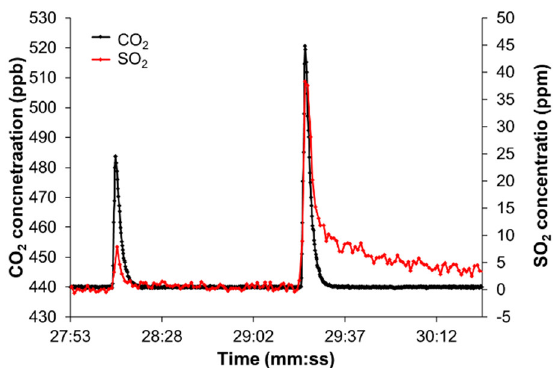
Figure 1. Graphs of CO 2 and SO 2 . The left peak is not impacted by VOCs, since SO 2 and CO 2 returned to background concentrations at the same time. The right peak of SO 2 was impacted by VOCs, visible by a tail behind the peak in which the SO 2 signal is returning very slowly to the background concentration.